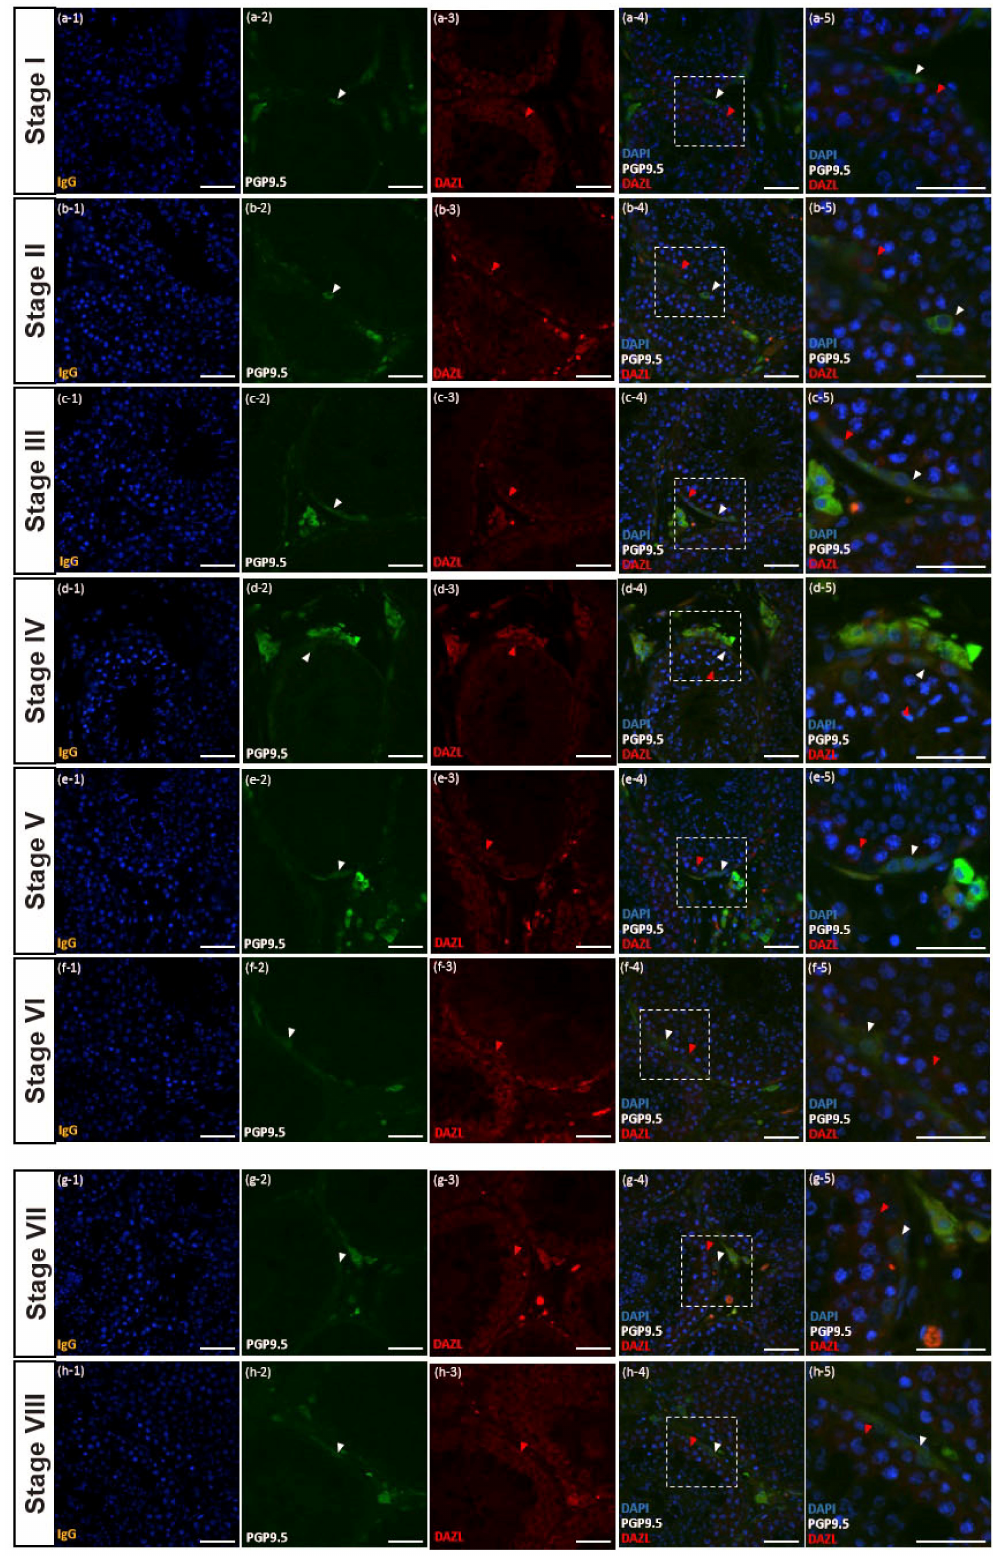
Figure 4. Reproductive stage-dependent expression of PGP9.5 and DAZL in the spermatogonia of a post-pubertal donkey. PGP9.5 immunolabeling was discovered in the cytoplasm of spermatogonia in the post-pubertal stage co-stained with DAZL ( a – h ). The white arrowhead indicates germ cells immunolabeled with PGP9.5. The red arrowhead indicates germ cells immunolabeled with DAZL. The size bar = 50 µ